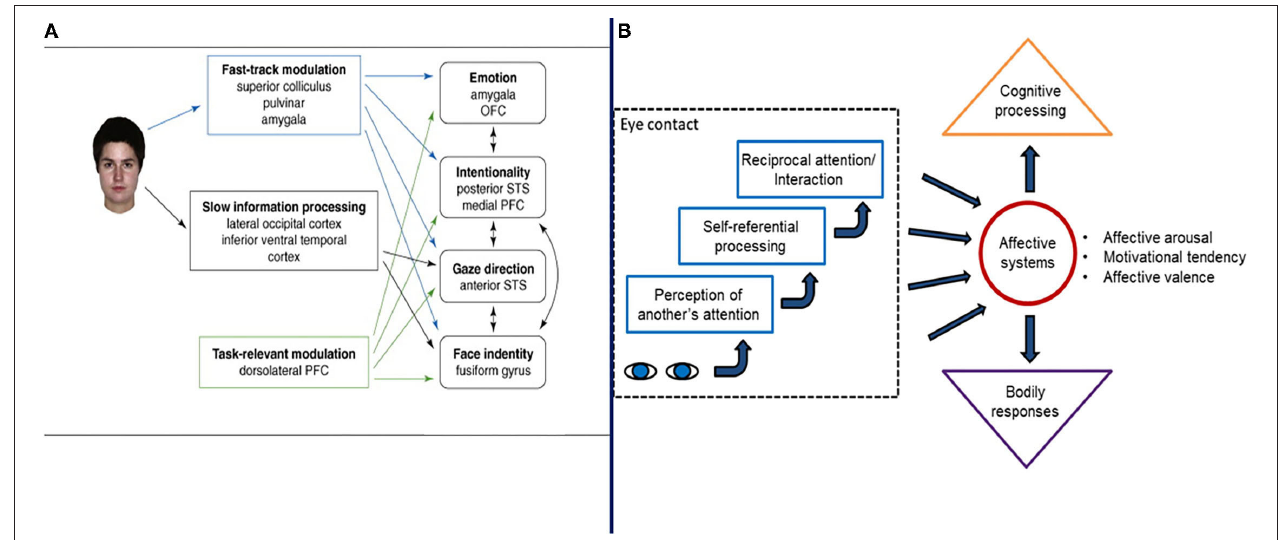
FIGURE 4 | Two illustration of the mechanisms and processes involved in the eye contact effect from Senju and Johnson (83) (A) and Hietanen (52) (B), respectively. Figures reprinted with permissions from, (Left panel) Trends in Cognitive Science, Elsevier, and (Right panel) Frontiers in Psychology,